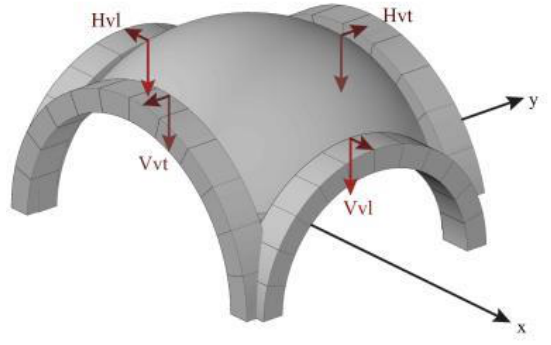
Figure 15. Forces transferred by the vault on the four arches along the perimeter